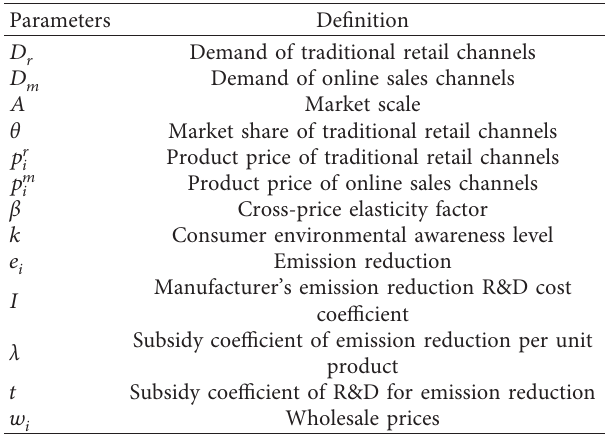
Figure 2: Decision sequence diagram. Table 1: